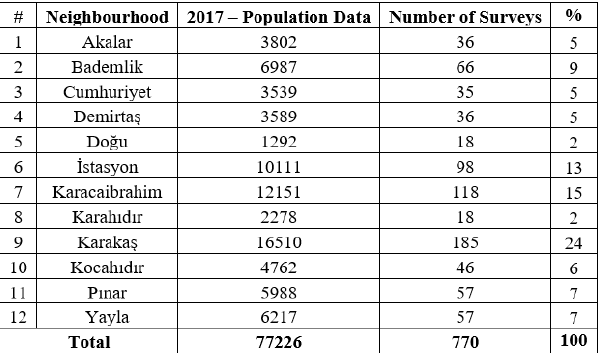
The highest and lowest survey percentages in the neighborhoods are Karakas with 24% of surveys, Karacaibrahim with 15% of surveys and Dogu and Karahidir with 2% (Figure 6).